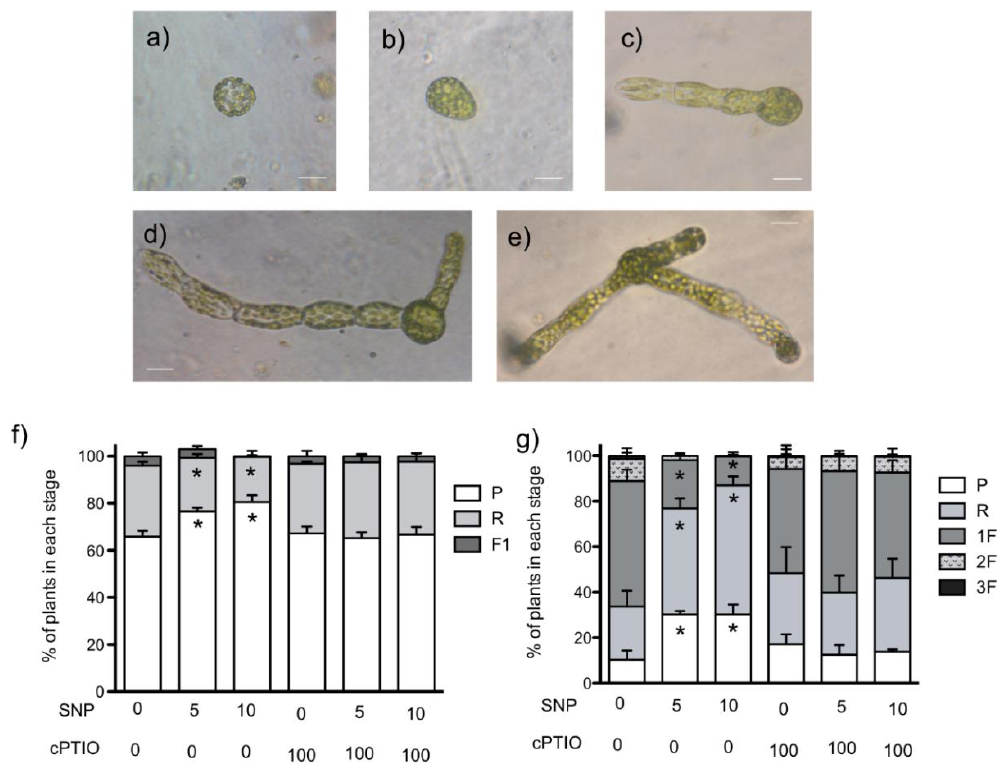
Figure 2. Effect of NO donors in protoplast regeneration and protonema initiation. Representative images of development stages observed during protoplast regeneration process: ( a ) protoplast; ( b ) regeneration started, ( c ) regenerated plant with one chloronema filament, ( d ) plant with two chloronema filaments and ( e ) plant with three chloronema filaments. Isolated protoplasts were allowed to initiate regeneration for 24 h before starting treatments with NO donor sodium nitroprusside (SNP) and/or scavenger 2-(4-carboxyphenyl)-4,4,5,5-tetramethylimidazoline-1-oxyde-oxyl-3-oxyde (cPTIO) at different concentrations in µM. Treatments lasted five days. ( f ) Percentage of plants in each development state at 3 days after isolation (DAI) and 2 days under treatment. ( g ) Percentage of plants in each development state at 7 DAI and 5 days under treatment. Scale bar = 30 µm ( a , b ); 50 µm ( c – e ). Three independent experiments were analyzed by one-way ANOVA and Tukey´s multiple comparison test. Asterisks indicate statistical differences with control at p < 0.05.